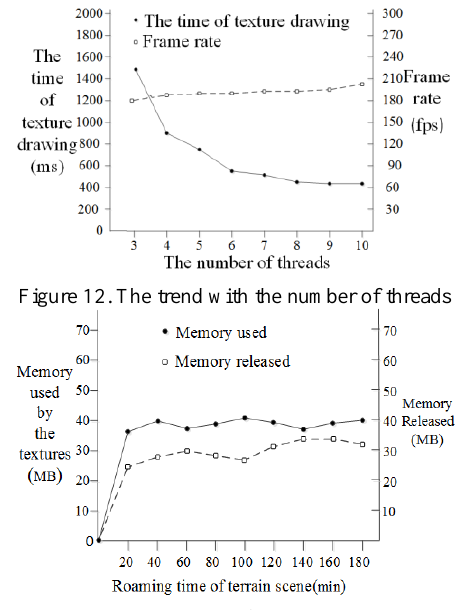
Figure 13. The trend of Computer